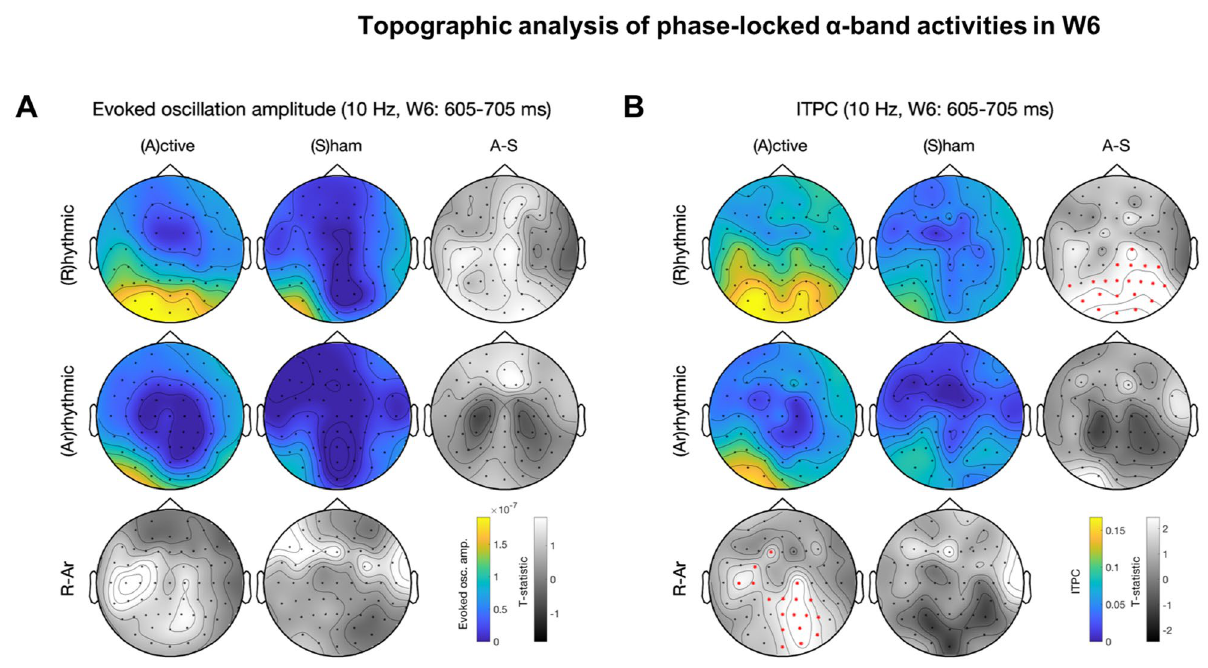
Figure 5. Topographic analysis of phase-locked α-band activities in W6. See Fig. 4 for panel layout description. ( A ) Evoked oscillation amplitude. ( B ) ITPC. Rhythmic-active stimulation elicits widespread activation. Note that ( B ) continues to show significant difference between conditions whereas ( A ) does not. A significant lateralized parieto-occipital cluster exists in the rhythmic- vs. arrhythmic-active stimulation contrast. Time windows